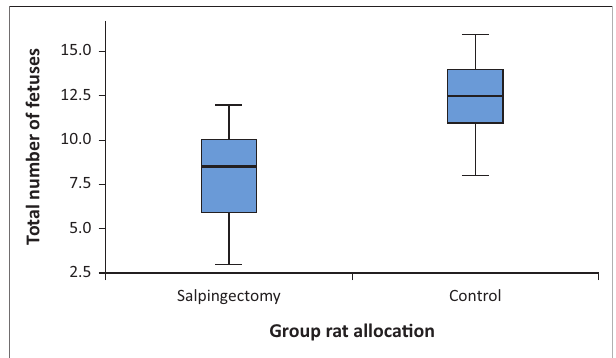
FIGURE 2: Box plot demonstarting the mean total number of foetuses at the time of termination in the salpingectomy and control groups. The blue boxes indicate the standard deviation for each individual group and the whiskers show the highest and lowest recorded values for the salpingectomy and the control groups, respectively. TABLE 1: Mean weight of females at the time of surgery and termination for the salpingectomy and control groups. Number of foetuses in the right and left uterine horns in the salpingectomy and control groups. Variables measured